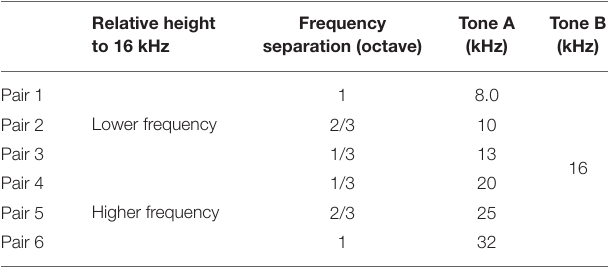
TABLE 1 | Sound frequency of tone pairs used in the